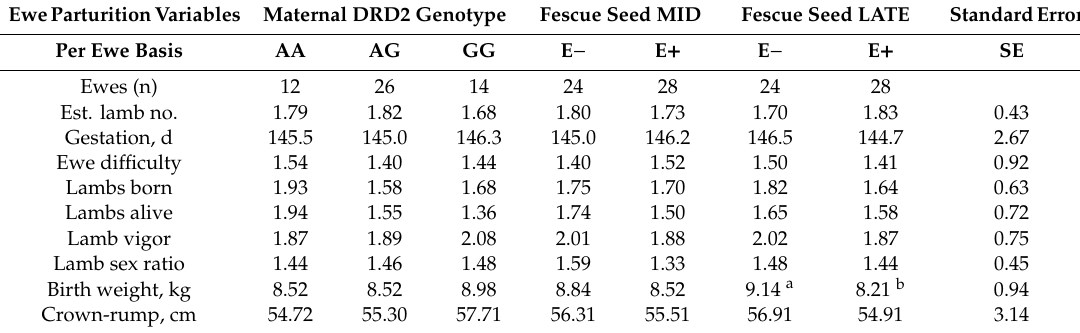
(Table 2). Lamb birth weight (kg/ewe) did not differ when E+ fescue seed was fed during MID (d 35 to 85) gestation. Lamb birth weight (kg/ewe) was decreased ( p = 0.02) by 10.2% in E+/E+ and E − /E+ ewes. Birth weight was strongly associated with lamb weaning weight (r = 0.81; p < 0.0001) in this study. Table 2. Parturition characteristics in ewes of different genotypes (DRD2 SNP) fed E − or E+ seed. Table 2. Parturition characteristics in ewes of di ff erent genotypes (DRD2 SNP) fed E − or E + seed.